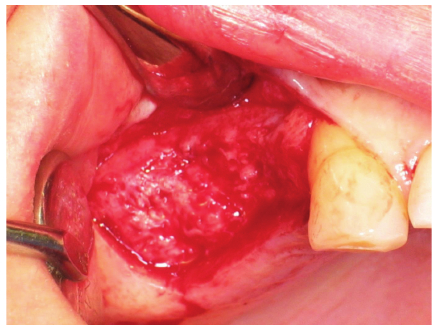
Figure 8: Flap reflection.